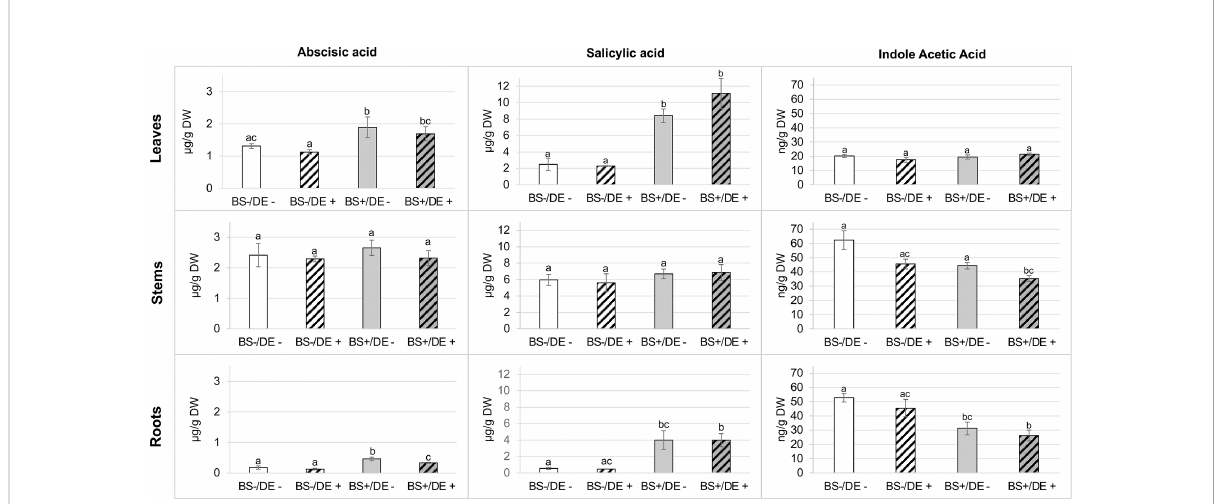
FIGURE 7 Effect of BS treatment on abscisic acid, (ABA), salicylic acid (SA) and indole acetic acid (IAA) content of grapevine plantlet leaves, stems and roots. Grapevine micro-cuttings were transplanted in a solid medium supplemented with BS 0.1% (v/v, “ BS+ ” ) or water ( “ BS- ” as control). At 4 wpt, they were divided into two sets: one treated by immersion in a defense elicitor solution (DE+) and the other one in water as control (DE-). Two days later, leaves, stems and roots were collected. Extracts were prepared and analyzed by LC-MS. The bars represent the standard deviations and a signi fi cant difference is observed when the treatments have no letter (a or b) in common ( P < 0.05) after a Kruskall-Wallis